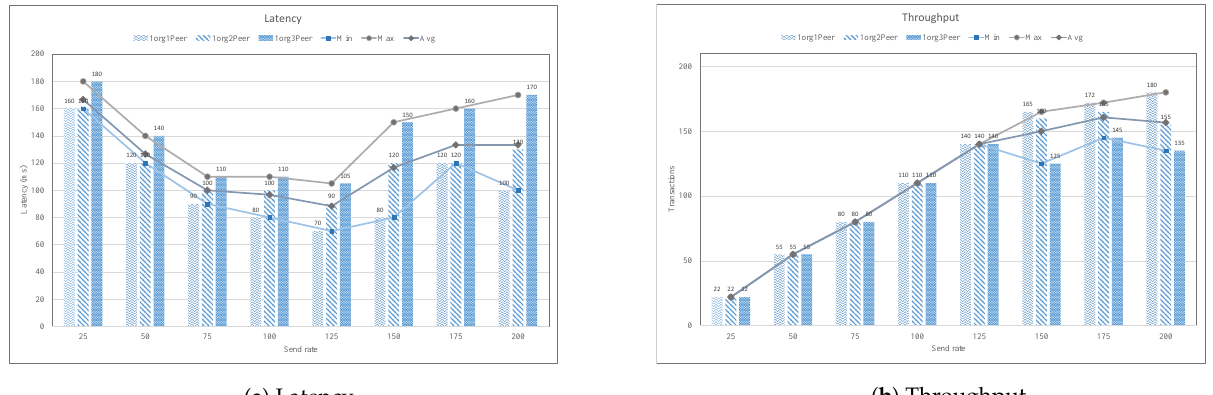
Figure 16. Impact of varying peer node with different transaction rate.